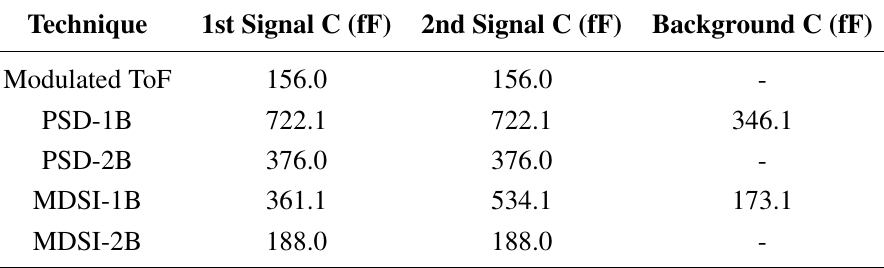
Table 3. Minimum capacitance for all of the ToF measurement